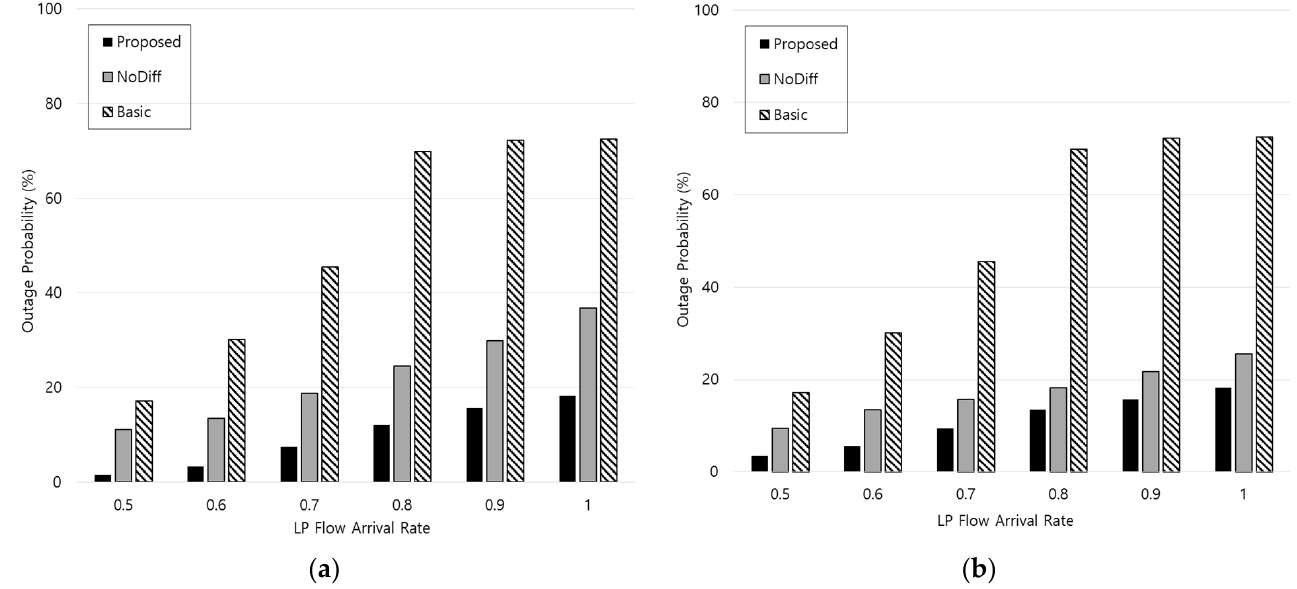
Figure 6. Outage probability of HP flow requests: ( a ) η = 1/3, ξ = 1/3, ( b ) η = 2/3, ξ = 1/3.